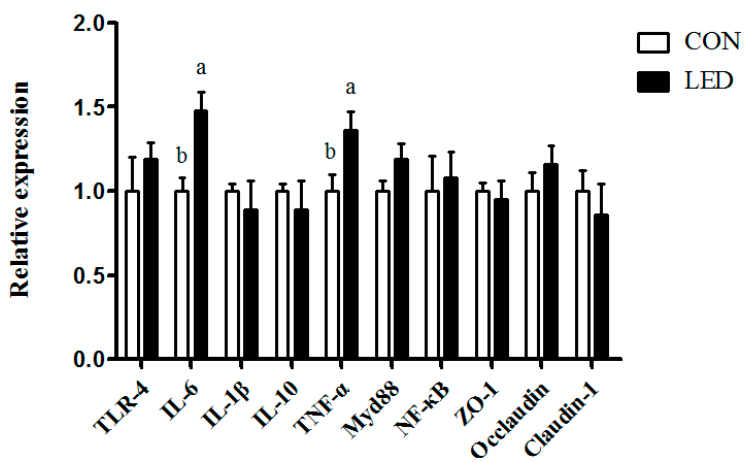
Figure 2. Effect of different energy levels during gestation on mRNA abundance of innate immune-related genes in ileum of newborn pigs. TLR-4 , Toll-like receptor-4; IL , interleukin; MyD88 , myeloid differentiation factor 88; NF- κ B , nuclear factor kappa B; TNF- α , tumor necrosis factor α . Values are expressed as mean values with their standard errors; means with different superscript letters are significantly different ( p < 0.05); the replicated number of each group is 6.